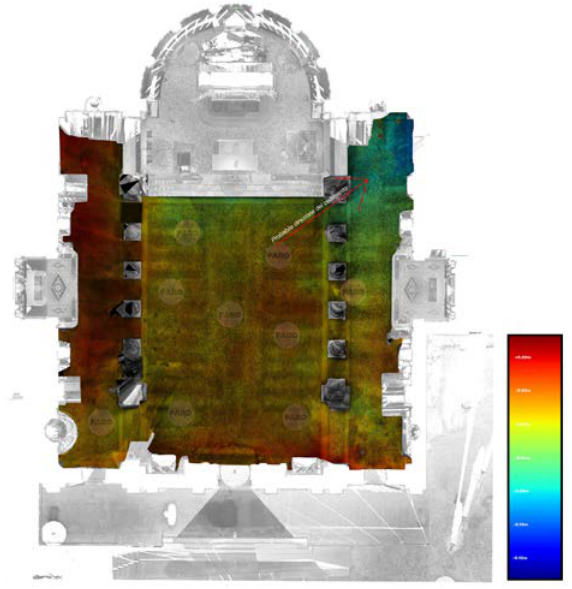
Figure 12. Digital Elevation Model of the internal floor